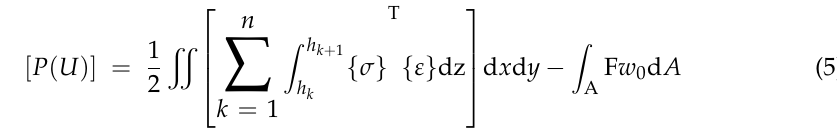
The potential energy function [ P ( U )] because of the strain energy and transverse harmonic force is shown in Equation